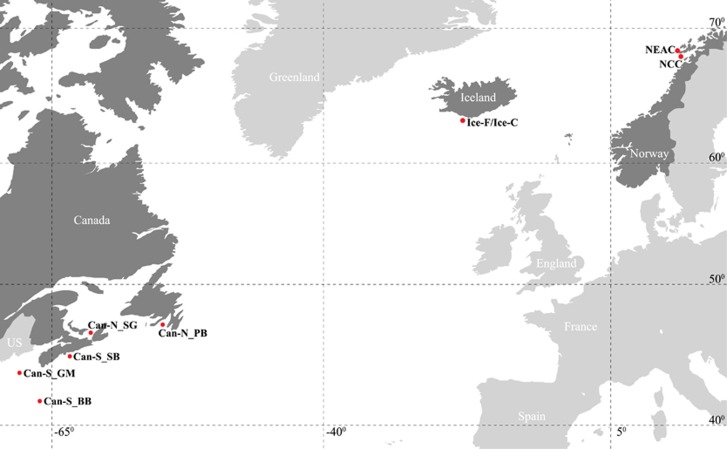
Map showing the sampling locations of the Atlantic cod populations used in the present study. With one exception, red dots indicate the position where the samples were collected; the Icelandic samples were collected at several locations in the waters around Iceland and later categorized as Frontal or Coastal, based on Data Storage Tag profiling. See Figure 1 in Thorsteinsson et al. (2012) for a detailed view of the Icelandic sampling localities and see Table 1 for a detailed description of the populations in the present study. Can-N_PB, Placentia Bay; Can-N_SG, Southern Gulf of St Lawrence; Can-S_SB, Sambro; Can-S_GM, Gulf of Maine; Can-S_BB, Browns Bank; Ice_F, Iceland Frontal; Ice_C, Iceland Coastal; NEAC, Northeast Arctic cod; NCC, Norwegian coastal cod. The map was modified from http://www.graphic-flash-sources.com/world-vector-map/ using Adobe Illustrator CC.